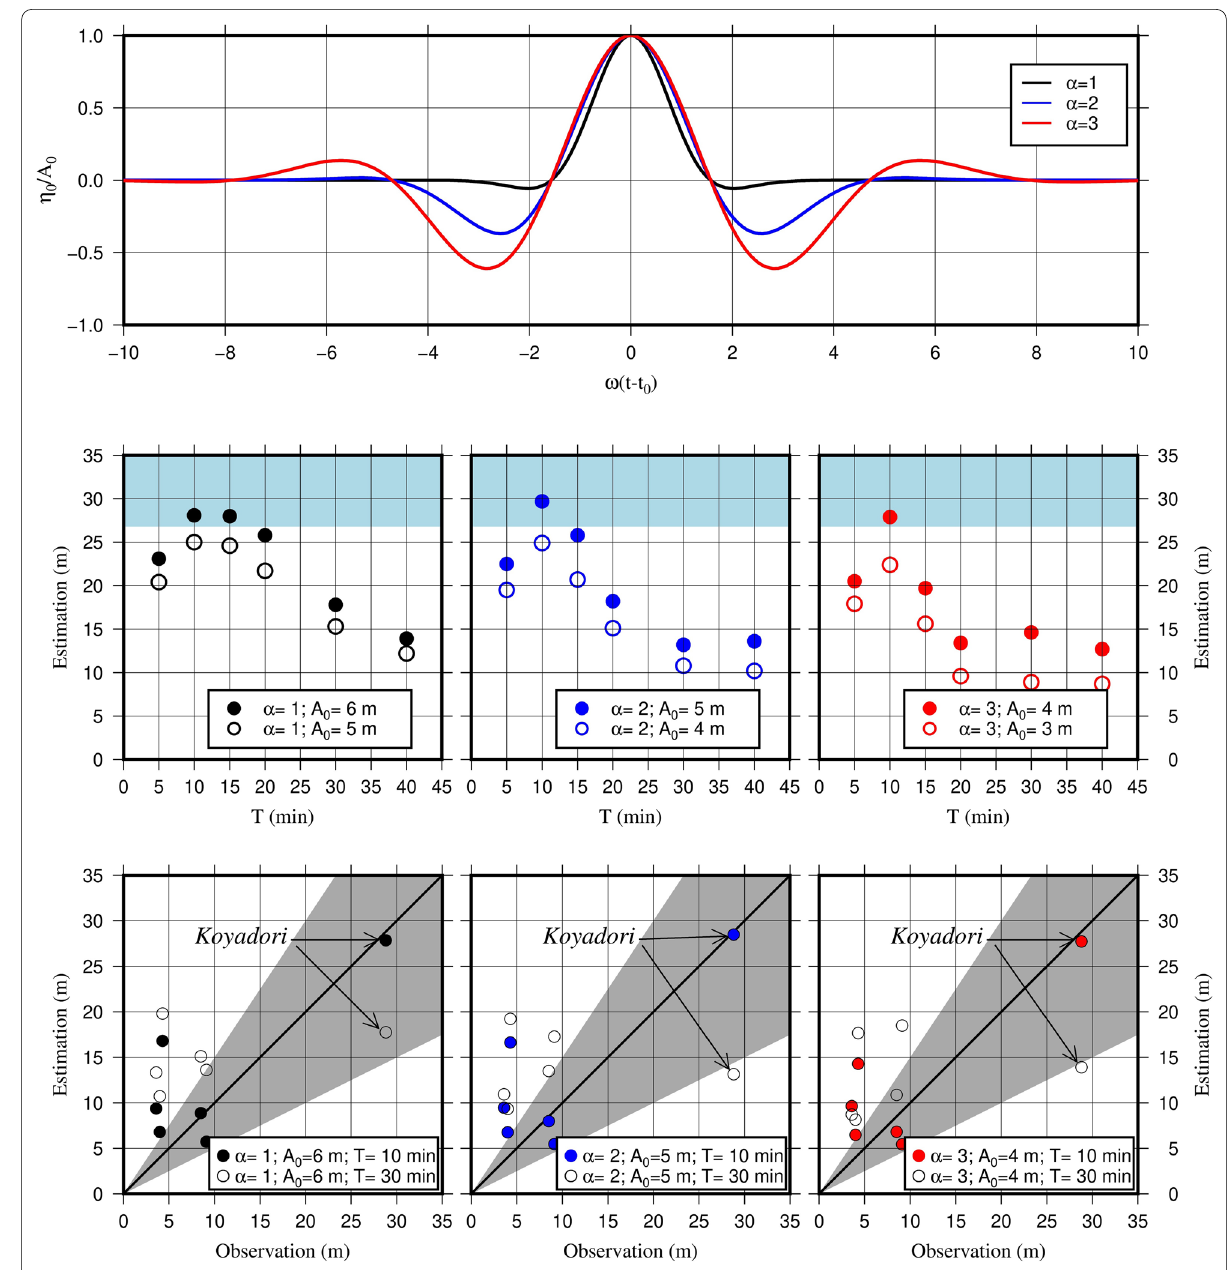
Fig. 3 Results of the numerical experiment. Incident waveforms (upper panel), maximum simulated height along the Koyadori valley (middle panels), and comparison of simulated heights and the observations (bottom panels). The gray area in the bottom panels indicates an error range within